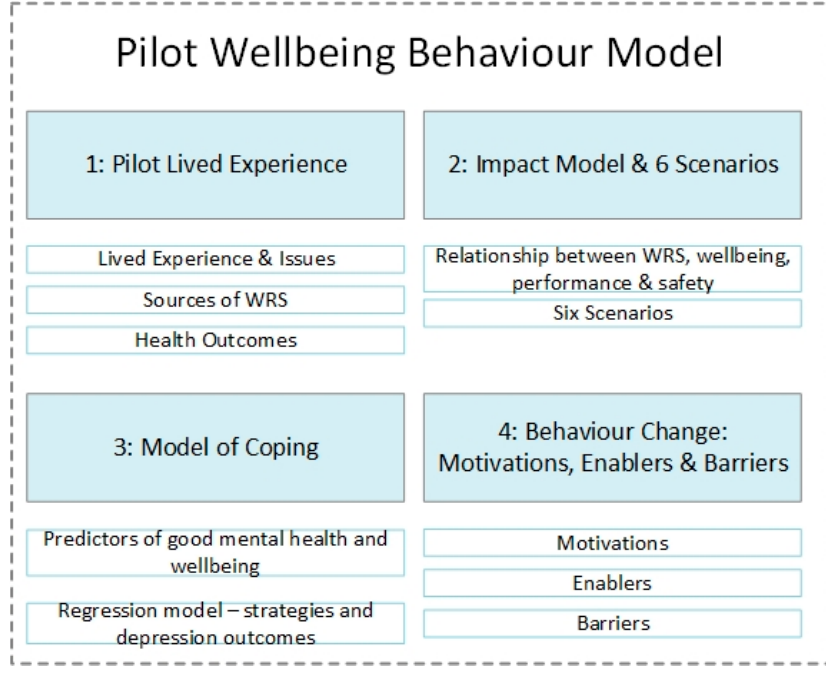
Figure 2. Pilot wellbeing behavior model .